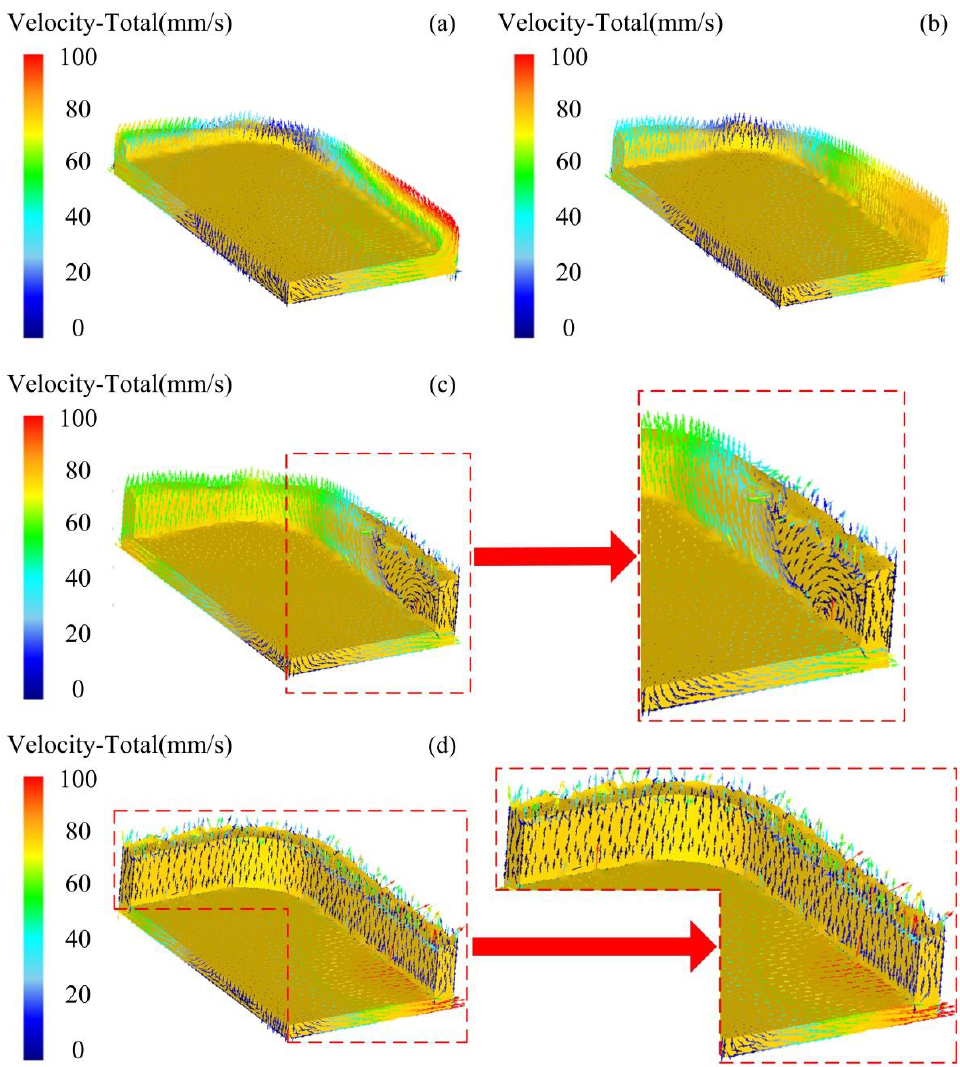
Figure 4. Velocity distribution during the filling process of mobile phone shell at ( a ) 0.25 mm, ( b ) 0.5 mm, ( c ) 0.75 mm, and ( d ) 1 mm displacements of the top mould. 0.5 mm, ( c ) 0.75 mm, and ( d ) 1 mm displacements of the top